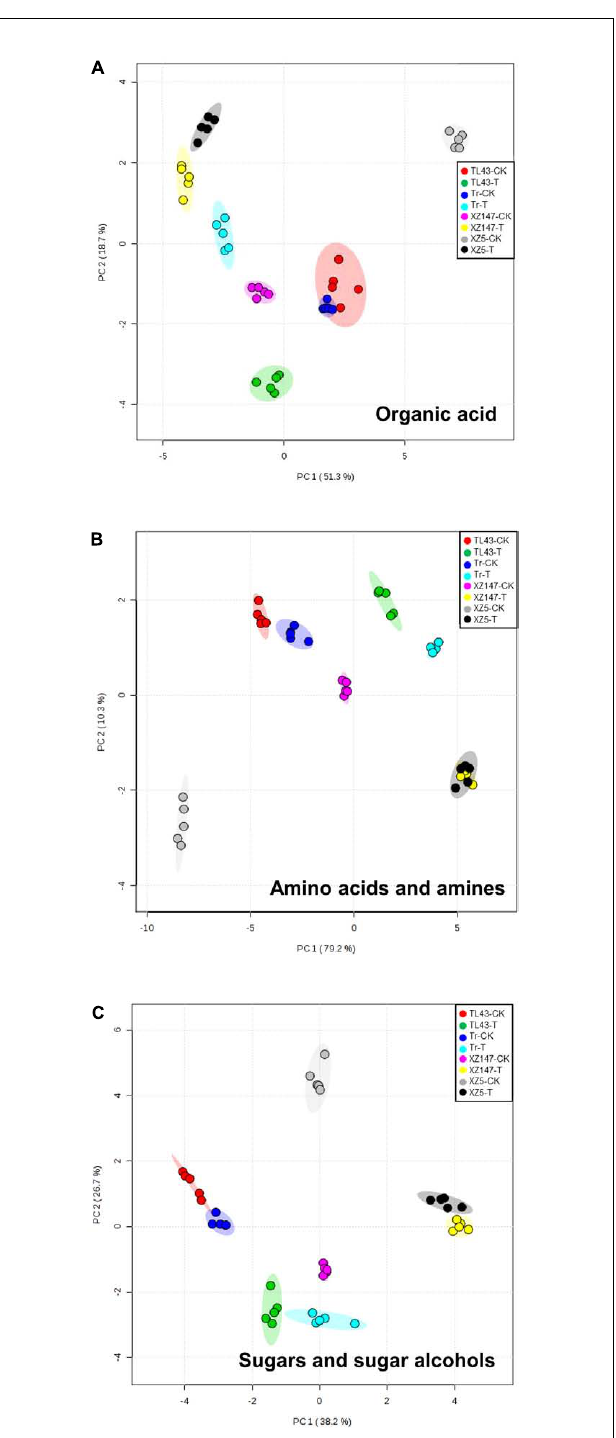
FIGURE 3 | Principal component analysis (PCA) of metabolic profiles in grains of four barley genotypes under the two water treatments. (A) PCA of fraction I, organic acid; (B) PCA of fraction II, amino acids and amines; and (C) PCA of fraction III, sugars and sugar alcohols. CK, control condition with soil water content of 40%; T, water stress treatment with soil water content of 14%; Tr, Triumph; PC1, the first principal component; and PC2, the second principal